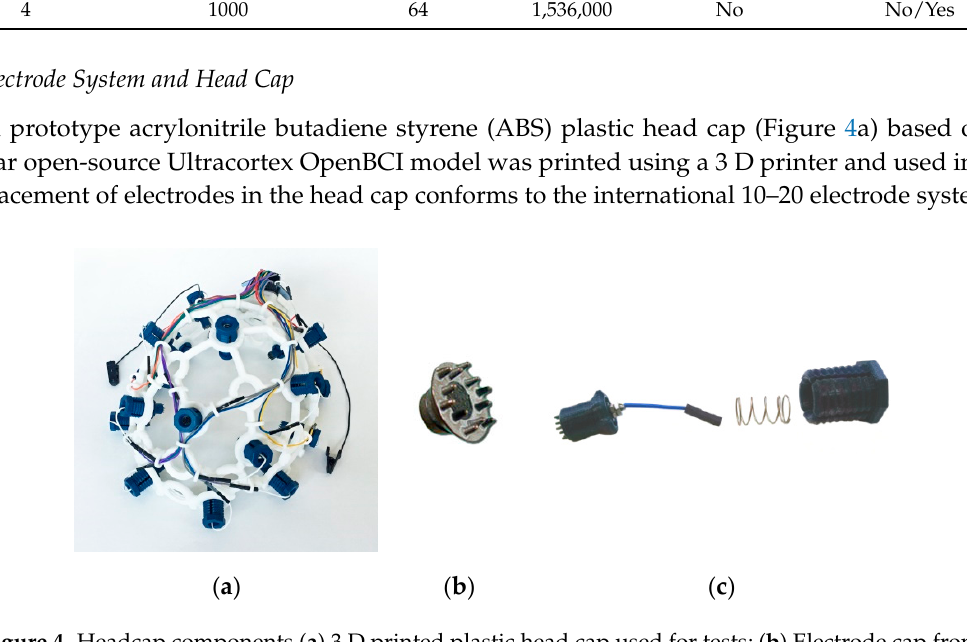
Figure 4. Headcap components ( a ) 3 D printed plastic head cap used for tests; ( b ) Electrode cap from Florida Research Institute; ( c ) plastic electrode holder with a spring system.